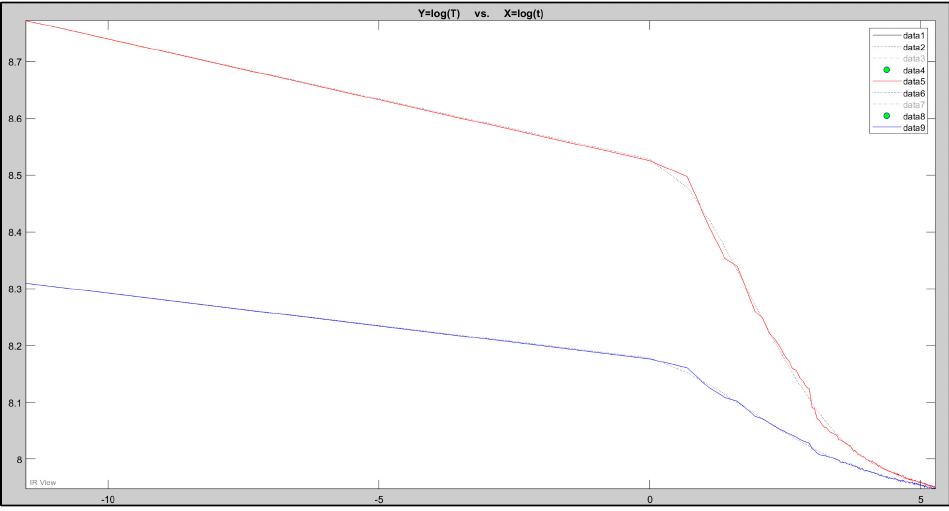
Figure 8. Five-degree polynomial fitting for sample 3.2 front surface (red—defected area pixel; blue—sound area pixel).